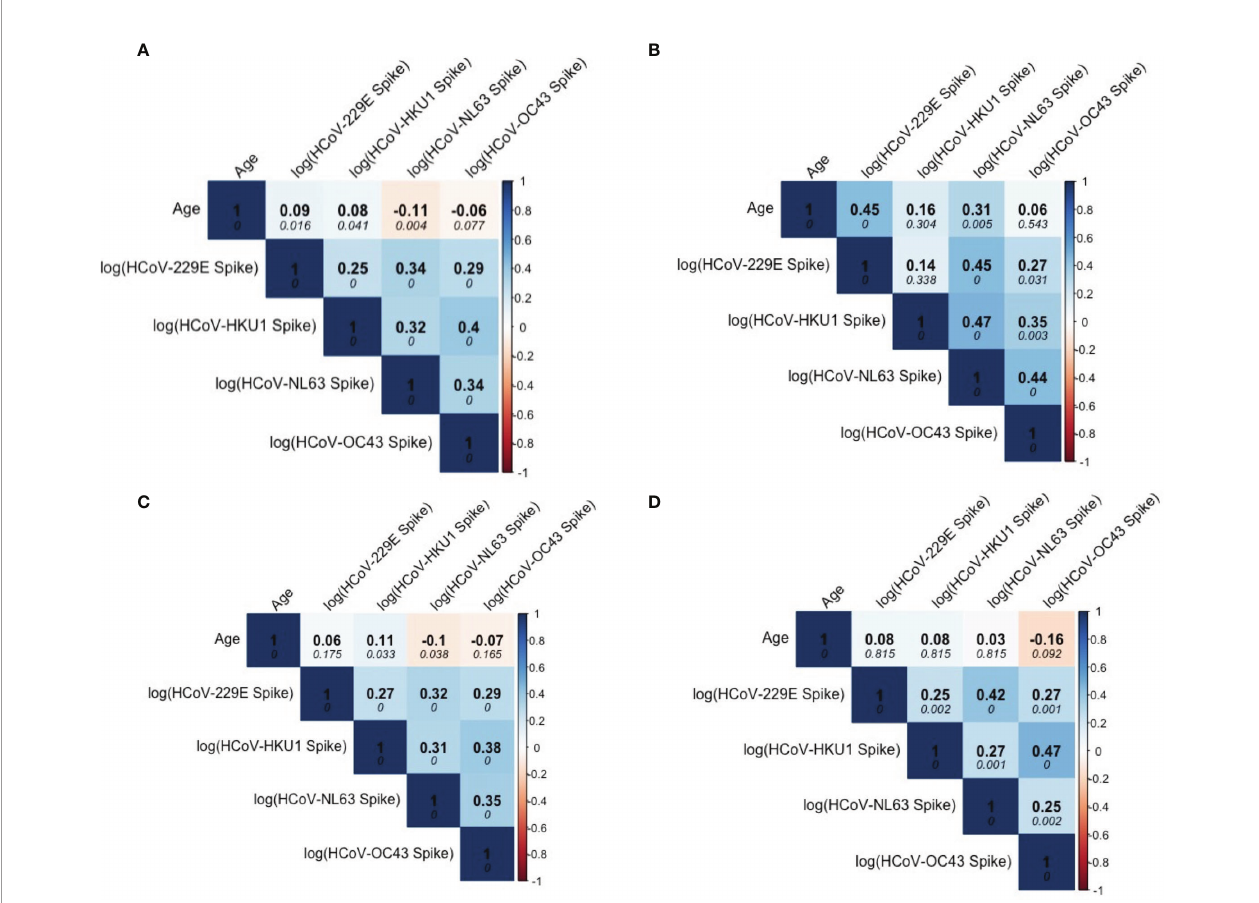
FIGURE 3 | Correlation matrix describing relationship among Age and HCoV-speci fi c IgG antibodies in SARS-CoV-2 sero-negative persons (N = 887). (A) describes correlations within the entire SARS-CoV-2 sero-negative population, comprised of all 2013 individuals (N = 407) and SARS-CoV-2 sero-negative individuals from 2020 (N = 480), which are further strati fi ed by age categories: (B) children ( ≤ 10 years old) (N = 587), (C) pre-teens to adults (11-69 years old) (N = 104), and (D) the elderly ( ≥ 70 years old) (N = 196). Darker colours represent stronger correlations. Spearman ’ s correlation coef fi cient is reported in each matrix (top numerical value). P-values are reported in